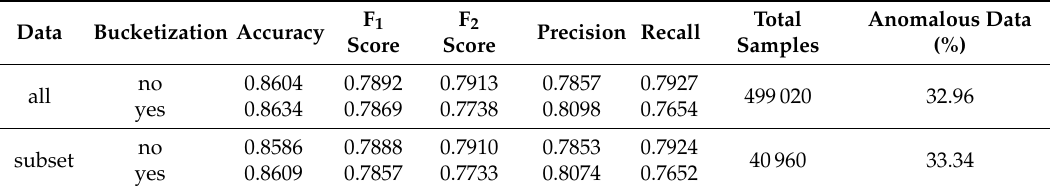
Table 4. [LHC] Models’ predictions quality depending on test set size. For quality measures definitions see Appendix